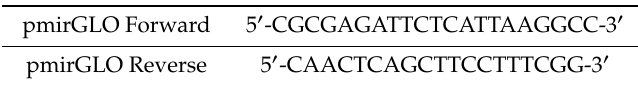
Table 2. Primers for sequencing.